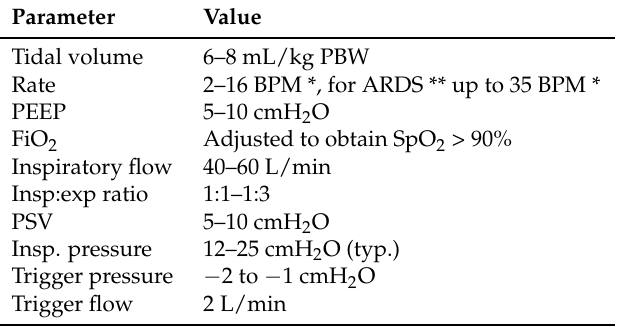
Table 1. Setting parameters for a mechanical ventilator [15]. * Breaths per minute. ** Acute respiratory distress